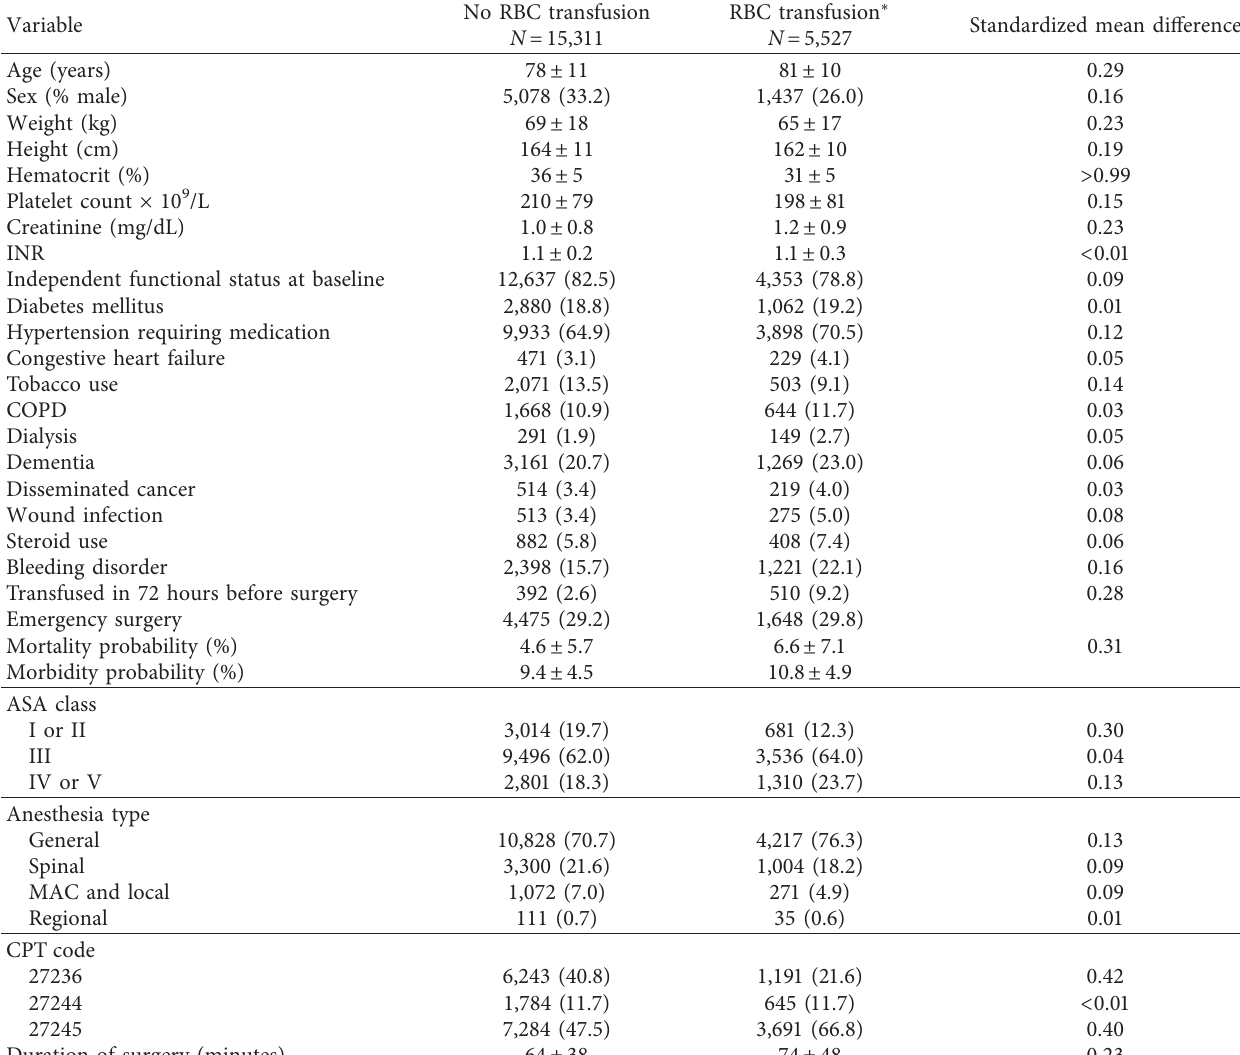
Table 1: Characteristics of all patients with eligible CPTs and complete study data.